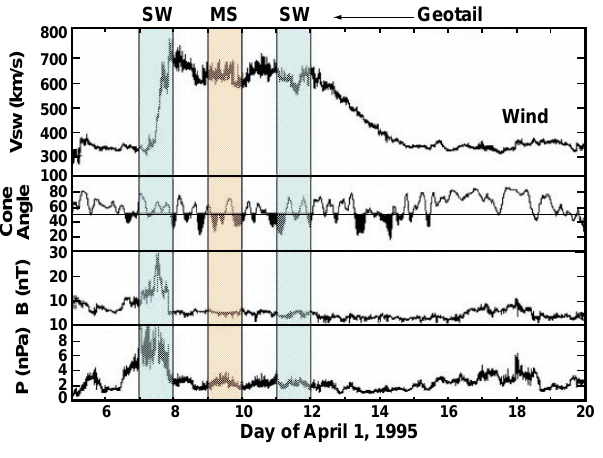
Fig. 4. Classic high speed stream, 5–20 April 1995. From top to bottom: solar wind high speed stream, cone angle, magnetic field magnitude, ram pressure.